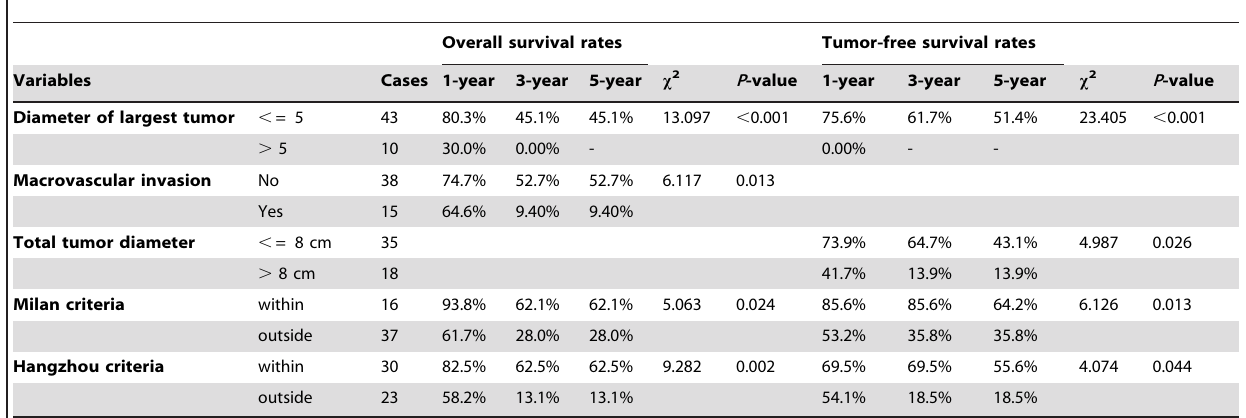
Table 3. Univariate analysis of variables related to post-liver transplantation survival (log-rank test) (P , 0.05 entered).